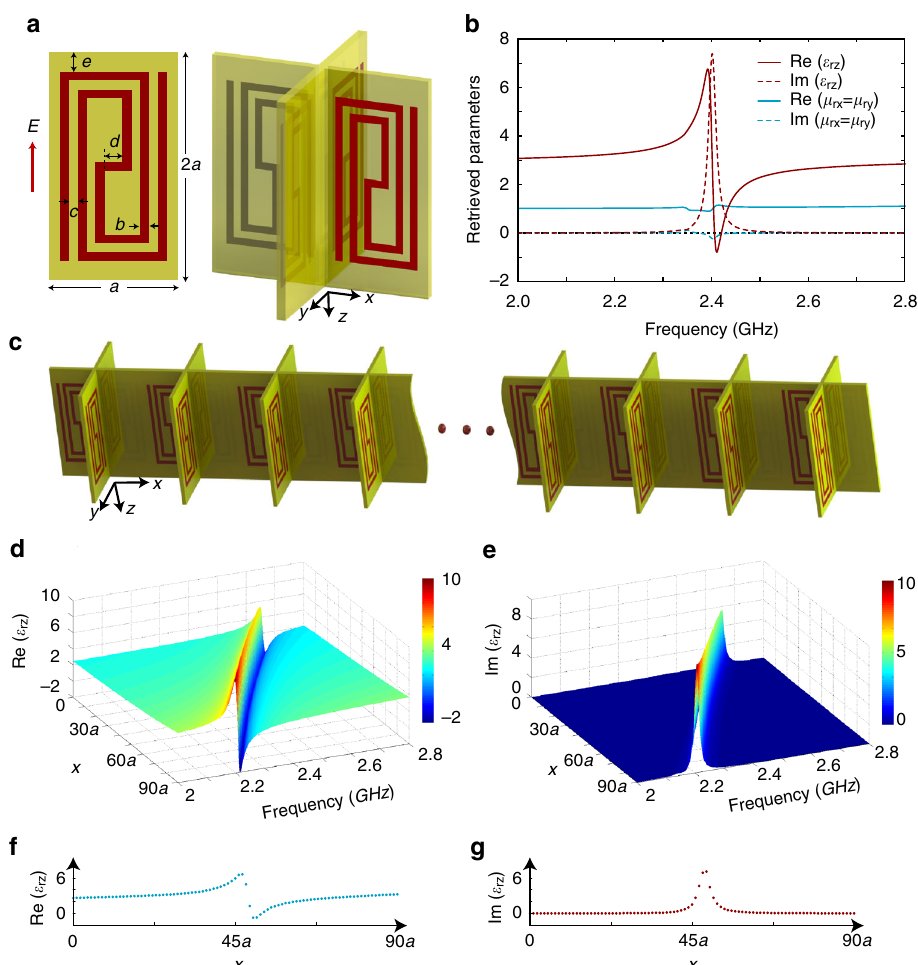
Fig. 3 Design of the inhomogeneous media with a one-dimensional spatial Kramers – Kronig pro fi le. a Geometry of the printed rolled-up wires and the formed two-dimensional (2D) arti fi cial medium. These rolled-up metallic wires (0.018-mm-thick copper with a conductance of 5.986 × 10 7 S/m) are printed on a 1-mm-thick dielectric substrate (F4 with a dielectric constant of 2.55 and loss tangent of 0.003). The dimensions a and 2 a denote the side lengths of the unit cell, b denotes the width of metallic wires, c denotes the distance between metallic wires, d denotes the length of the metallic segment in the center area, and e denotes the distance between the metallic pattern and the upper and lower edges of the unit cell. b The retrieved effective constitutive parameters with a = 6 mm, b = c = 0.4 mm, d = 0.35 mm, and e = 1.11 mm. The permittivity exhibits the Lorentz resonance model around 2.4 GHz and the permeability is approaching unity. c The strip-shaped structure composed of 91 unit cells along the x -axis with different geometric parameter e , which changes linearly from 1.6 mm to 0.7 mm with a step of 0.01 mm. d , e The retrieved real part and imaginary part of permittivity with respect to frequencies and spatial coordinate x , respectively. f , g The x -dependent real and imaginary parts of permittivity at 2.4 GHz, which satis fi es